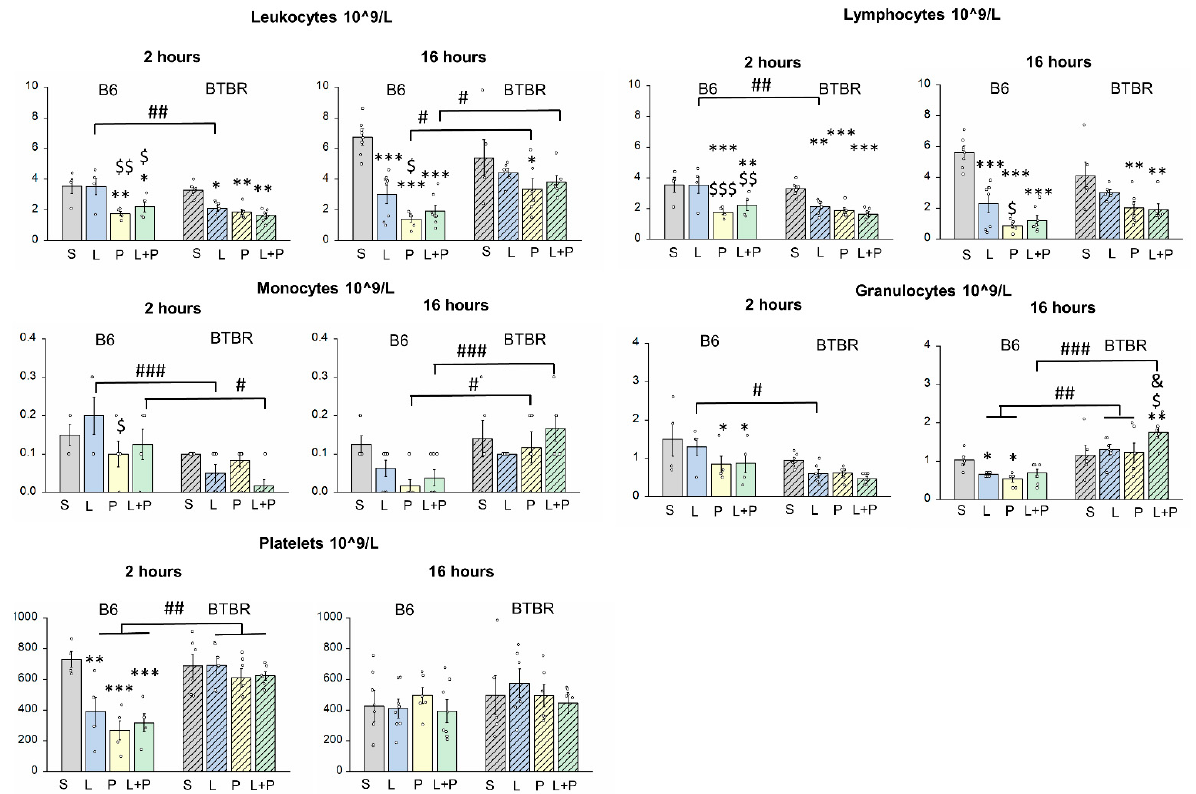
Figure 2. Numbers of leukocytes, lymphocytes, monocytes, granulocytes, and platelets in the blood of B6 and BTBR mice following systemic injection of polyI:C (P), LPS (L), or their combination (L+P). The control group is marked as S (received saline). The induced inflammation altered the counts of blood cells in different directions depending on the strain and time after injection. Factorial ANOVA, mean ± SEM, n = 4–8 per group. * p < 0.05, ** p < 0.01, *** p < 0.001 in comparison with saline control; $ p < 0.05, $$ p < 0.01, $$$ p < 0.001 as compared to the LPS group; & p < 0.05 as compared to the polyI:C group; # p < 0.05, ## p < 0.01, ### p < 0.001 in comparison with the corresponding B6